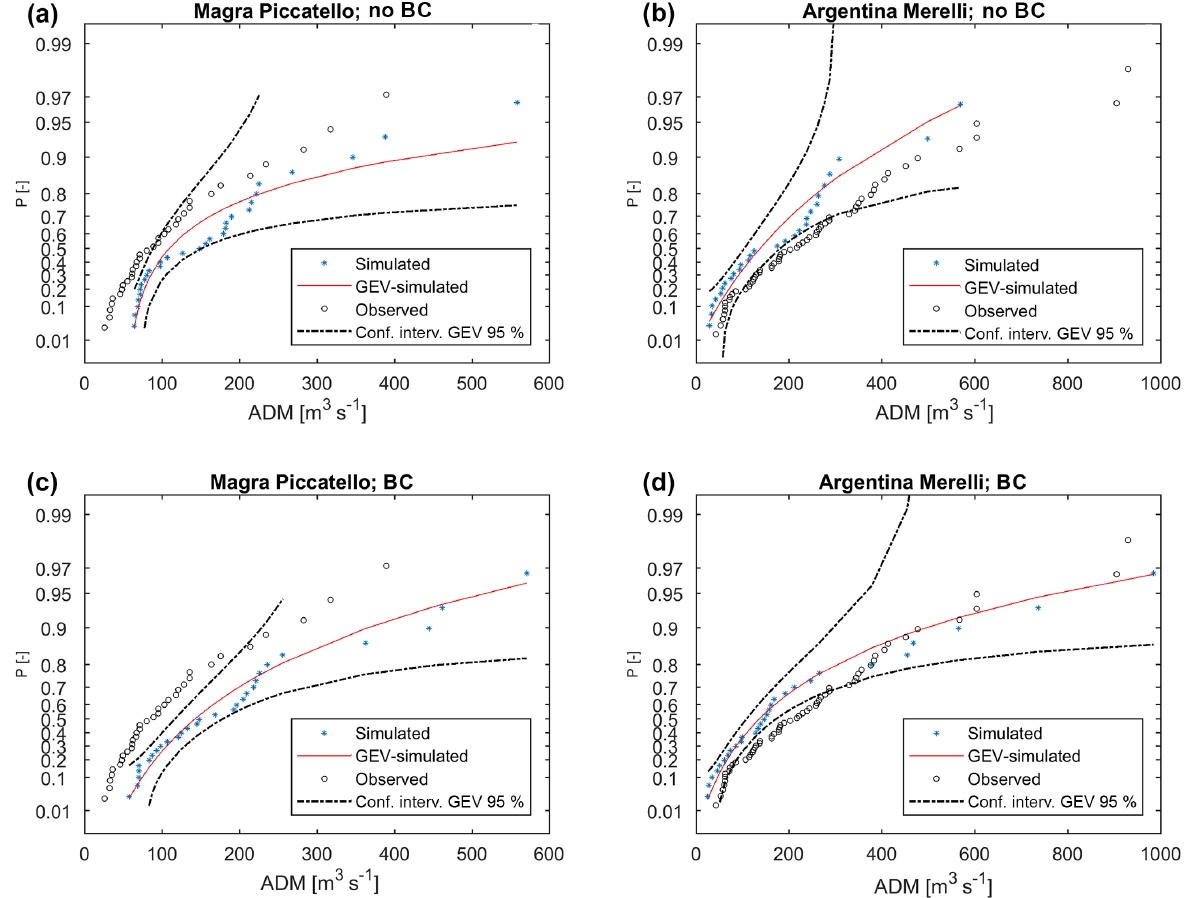
Figure 9. Same as Fig. 8 but for Magra closed at Piccatello (78km 2 ) and Argentina closed at Merelli (188km 2 ). Table 5. Kolmogorov–Smirnov (K–S) test with 5% significance. P values are reported together with verification of the null hypothesis (data can belong to or not belong to the same distribution). Results are reported for the two cases: with (BC) and without (No BC) rainfall bias